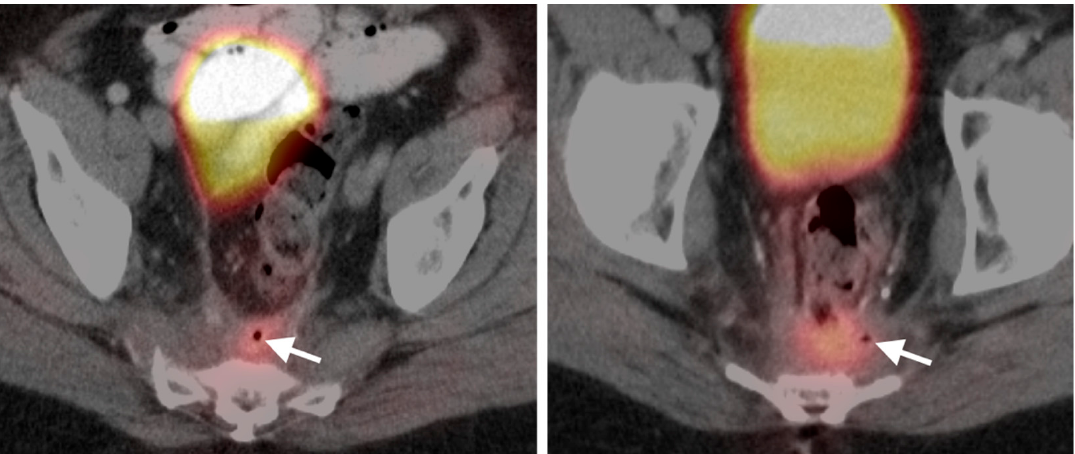
Figure 38. Fistula. Axial fused FDG PET-CT images of the pelvis. Increased metabolic activity on FDG PET-CT in an area of soft tissue thickening and the presence of a small focus of air (white arrows) are clues as to the presence of a post-treatment fistula. These are chronically inflamed and can also be associated with chronic